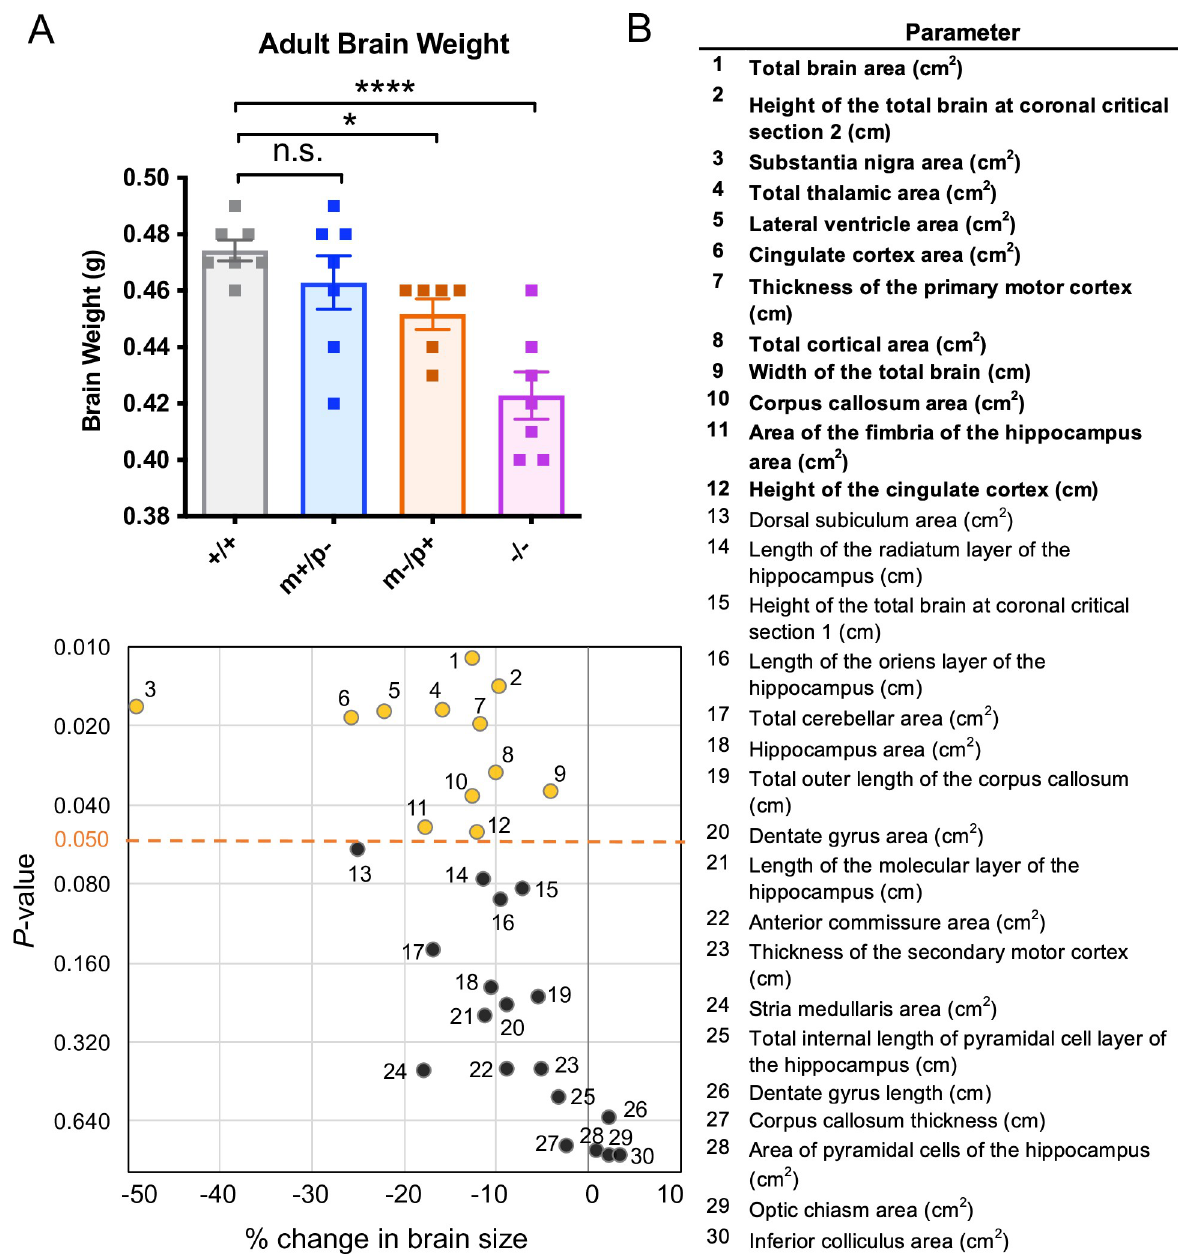
Fig 4. Trappc9 deficient mice show a decrease in brain weight and size. (A) Trappc9 deficient mice show a decrease in brain weight in a parent- of-origin manner. Trappc9 m-/p- mice (n = 7) have a significant reduction of brain weight (Fisher’s LSD test, ���� p < 0.0001) compared to that of the wild-types littermates (n = 7), whereas Trappc9 m-/p+ mice show a milder but significant reduction (n = 6, Fisher’s LSD test, � p < 0.05), and Trappc9 m+/p- mice have a normal brain weight (n = 7, n.s.). Female brains were used in this analysis. ( B) Trappc9 is associated with smaller brain size in adult homozygous knockout mice. X-Y plot shows the percentage of changes relative to the controls (100%) against the p -values (in log2 scale) testing the difference in 16-week aged Trappc9-/- mice comparing to their wild-type littermates at Lateral 0.72mm section (n = 4 brains in each group, 3 females and 1 male). Yellow dots with numbers represent a total of 12 regions (parameters in bold) that were significantly affected ( p < 0.05, 2-tail Student t -test; black dots: